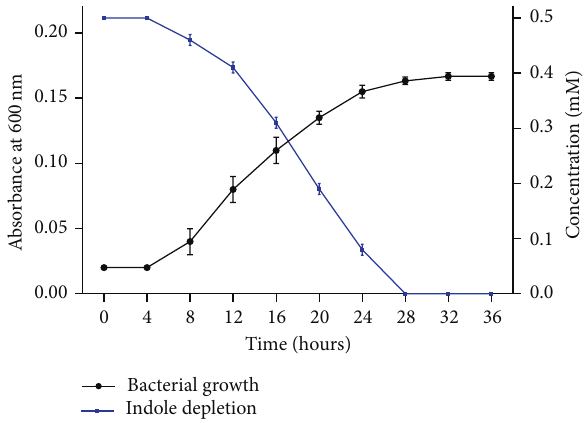
Figure 2: Growth of Lysinibacillus xylanilyticus strain MA on minimal medium containing 10mM sodium succinate and 0.5 mM indoleandindoledepletionby Lysinibacillusxylanilyticus